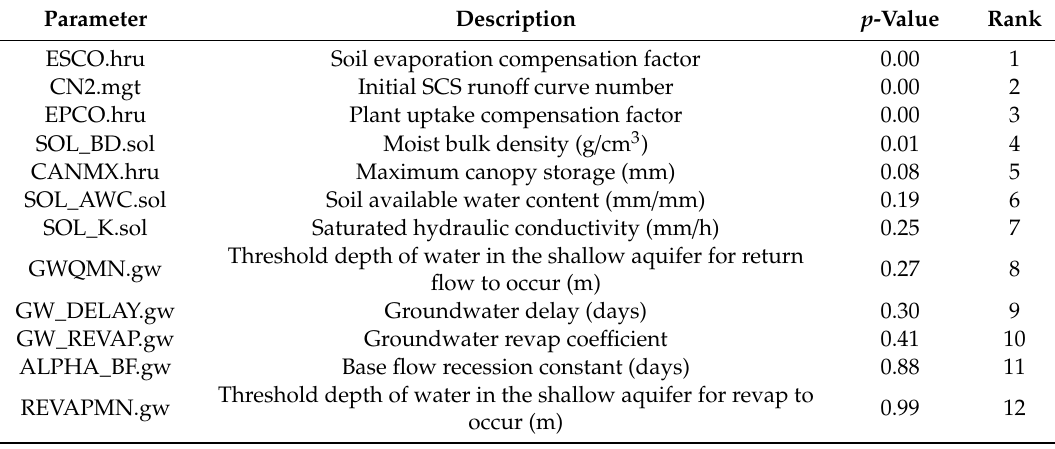
Table 2. Ranking of selected SWAT parameters with their p -values, based on sensitivity